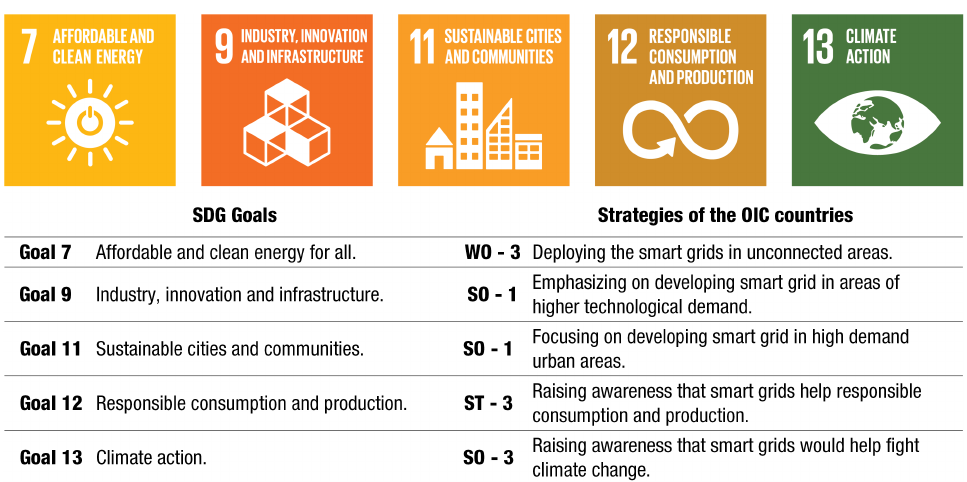
Figure 8. Smart Power management adaptation strategies in the OIC countries and the Sustainable Development Goals